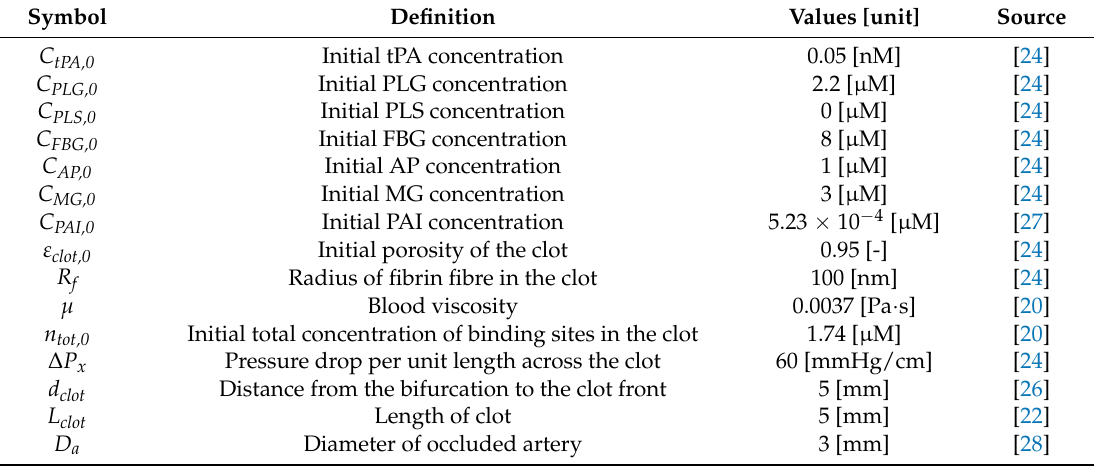
Table 3. List of input parameters and their values that were used in this